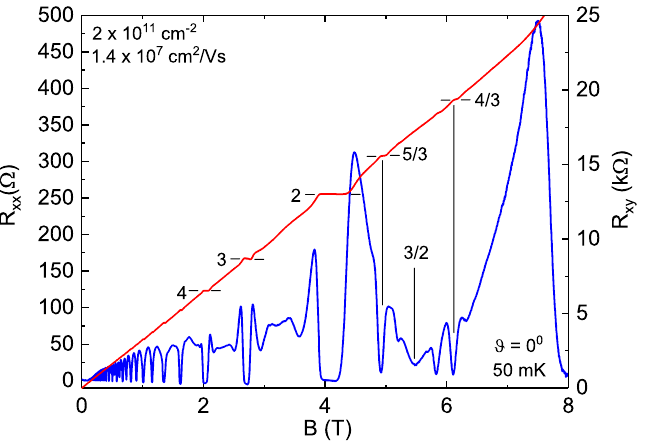
Figure 1. Overview of the diagonal and Hall resistances versus the magnetic field in a GaAs/AlGaAs heterostructure The diagonal resistance ( R xx ) and Hall resistance ( R xy ) are shown with short horizontal line segments marking some Integral (I) and Fractional (F) Quantized Hall Effects (QHE). Vertical lines indicate filling factors for the 4/3 and 5/3 FQHE and the 3/2 state. The carrier density and the mobility are indicated in the top left. The temperature and the tilt angle are indicated on the lower